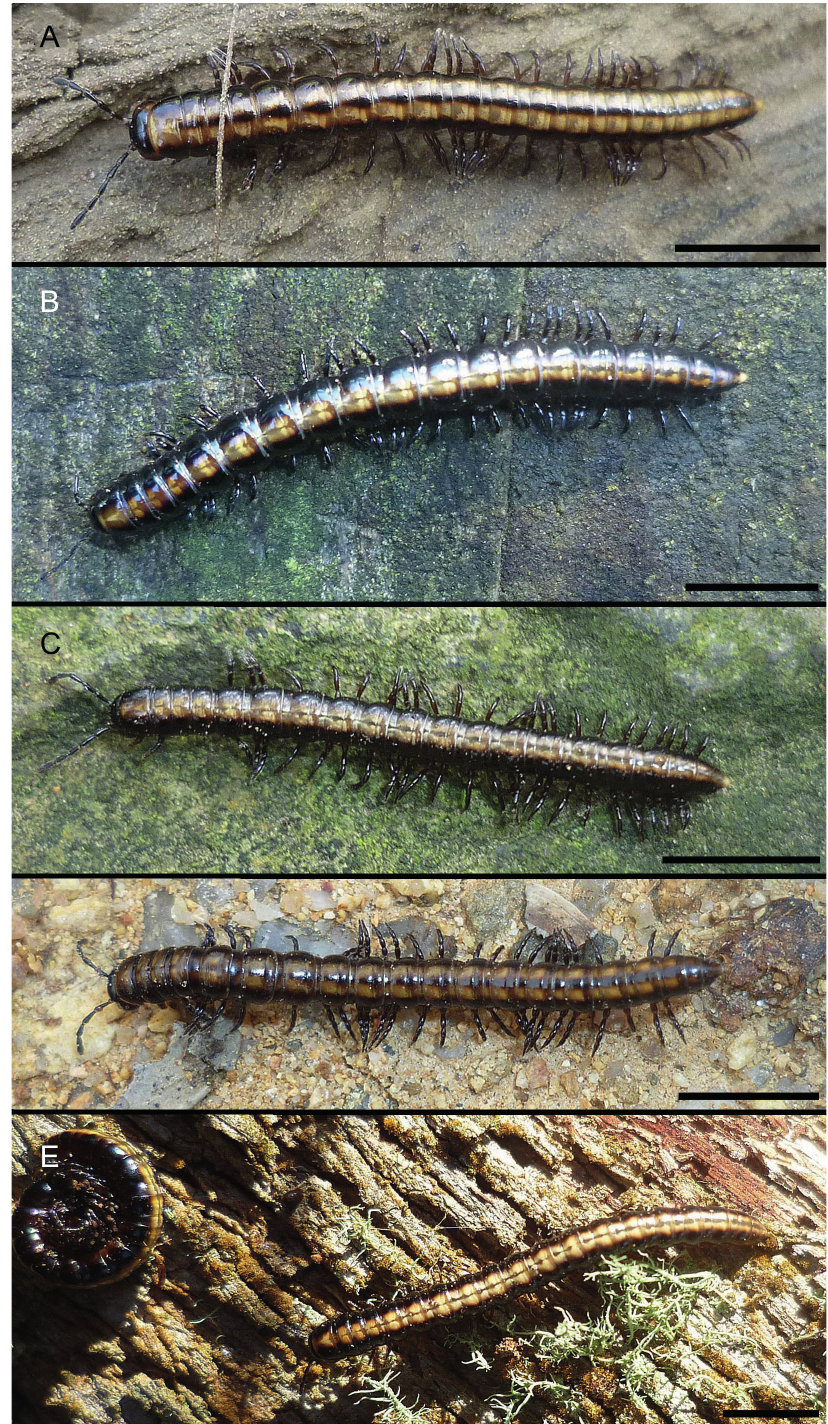
Fig. 26. Habitus and live colouration. A . Pogonosternum nigrovirgatum (Carl, 1902), ♂ from Adams Creek Nature Conservation Reserve (SMNG VNR016989). B . P. adrianae Jeeker, 1982, ♂ from Grand Ridge Road (NMV K-13349). C . P. laetificum Jeeker, 1982, ♂ from Toolangi State Forest, Two Hills Road. D . P. jeekeli Decker, sp. nov., ♂ from Warby-Ovens National Park, Taminick Gap Road. E . P. montanum Decker, sp. nov., ♂ (left, NMV K-12183) and ♀ (right, NMV K-13351) from Linden Roth Drive. Scale bars = 5